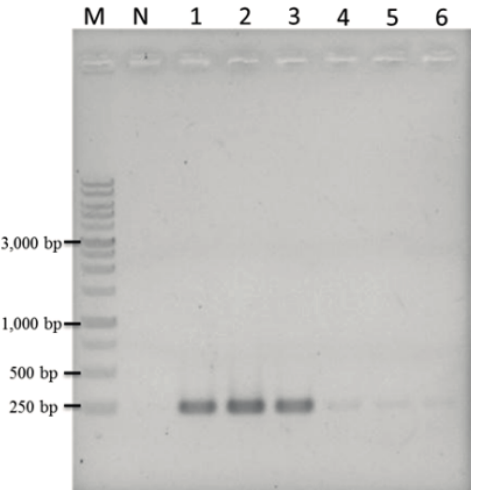
Figure 4. Determination of the PCR sensitivity using species-specific primers. The species-specific primers, F3 and B3, were used with genomic DNA from Taraxacum formosanum for a PCR reaction. The PCR reactions were performed after adding various amounts of Taraxacum formosanum genomic DNA. Lane M, 1 kb of DNA ladder marker; lane 1, 100 ng; lane 2, 20 ng; lane 3, 1 ng; lane 4, 100 pg; lane 5, 10 pg; lane 6, 1 pg, of extracted genomic DNA was added; Lane N, without TF genomic DNA.